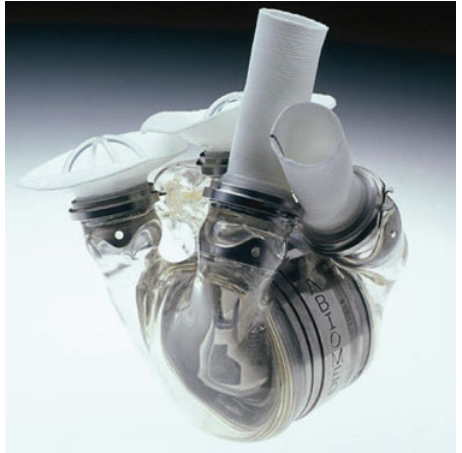
Figure 4 Abiocor TM